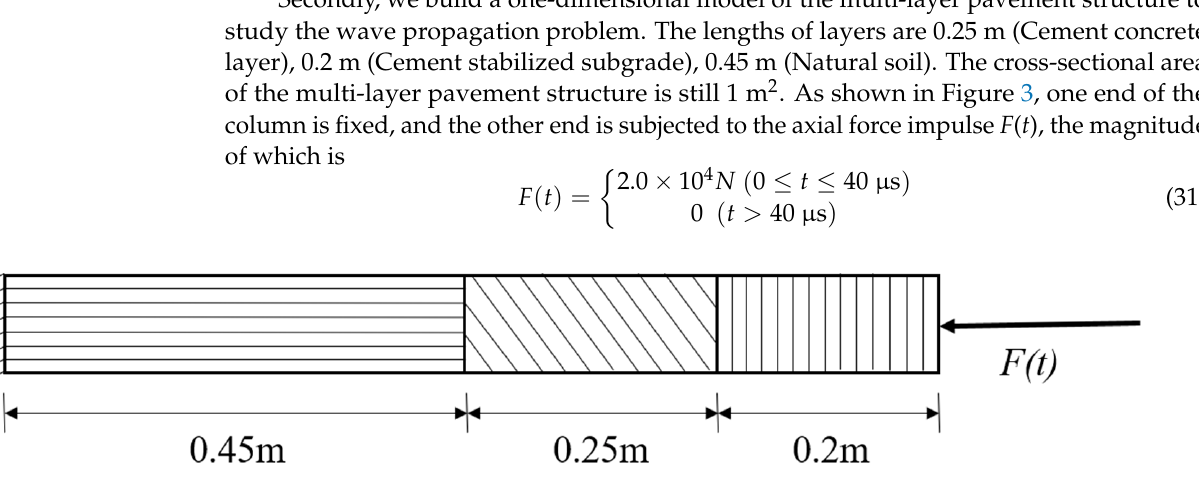
Figure 2. Elastic stress profiles between Newmark method and MDGFEM at 𝑡 = 60 μs and 𝑡 = 180 μs .